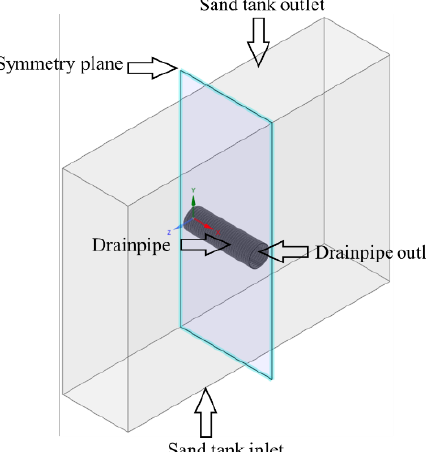
Figure 5. Schematic of the model and boundary conditions.